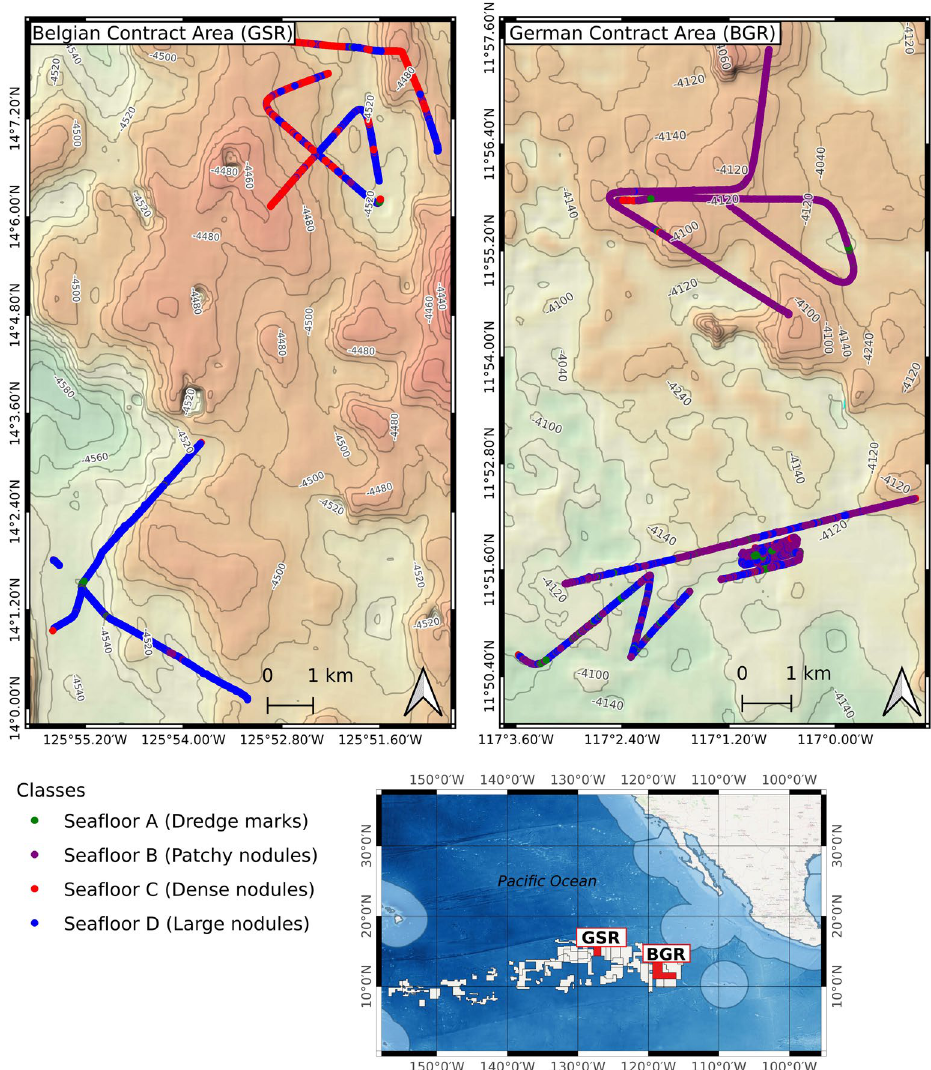
Figure 9. Maps of deployment tracks in both the German (BGR) and Belgian (GSR) contract areas. The deployment tracks are color coded by supervised classification results, and overlaid on our gridded multibeam bathymetric dataset. The boundaries of polymetallic nodule exploration areas were sourced from International Seabed Authority (https:// www. isa. org. jm), while the base map in the overview map was sourced from GEBCO (https:// www. gebco.